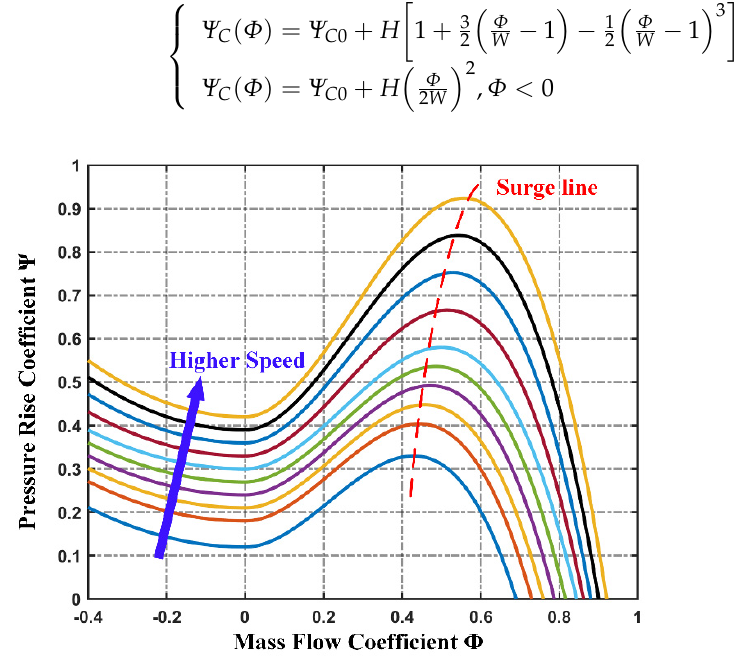
Figure 7. Compressor characteristic curves